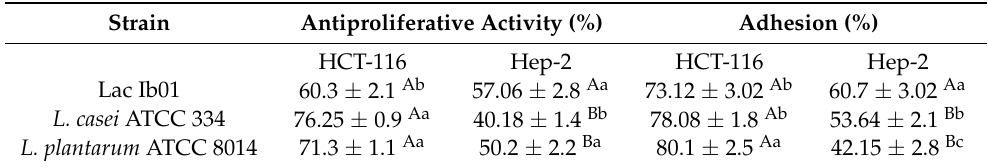
Figure 3. Antibacterial activity of reuterin extracts produced by Limosilactobacillus reuteri (OL468126.1) using different concentrations of glycerol solutions (200 mM, 300 mM, and 400 mM) against tested pathogens. Data are the mean values of three replicates, and the error bars indicate the standard deviation ( n = 3). Capital letters are used to indicate significant differences observed for the same strain at different concentrations of glycerol. Different small letters indicate significant differences between the strains under the same conditions ( p < 0.05). Table 3. Antiproliferative activity and adhesion ability of Limosilactobacillus reuteri (Lac Ib01) selected as candidate